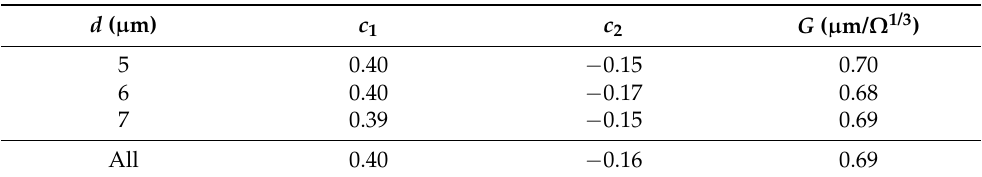
Table 1. Fitting parameters of the linear robust fit ( O = c 1 D / d + c 2 ) and the gain factor G for the separate measurements in Figure 4a,b. G was chosen, such that the mean measured electrical diameter D equals the nominal diameter d .